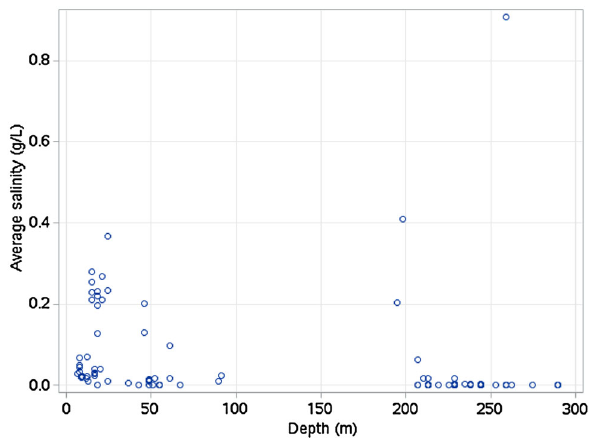
Fig. 7 Altitude of tube wells within clusters in the study area in Chakaria Upazila, Bangladesh, 12 February–13 May 2016. The result of ANOVA: F -value = 1.27 and p value = 0.2789